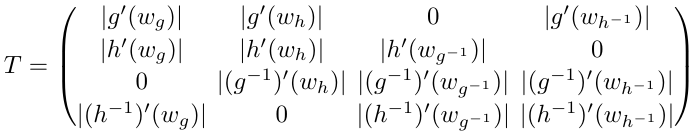
nonzero elements in each row and column, and the algorithm has error decreasing exponentially with n . The (cid:12)gure includes labels for words of length two, but also shows the images of circles under words of length three